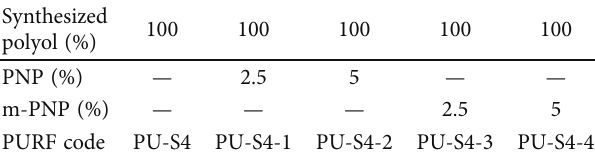
Table 2: Codes of prepared PURF nanocomposites.